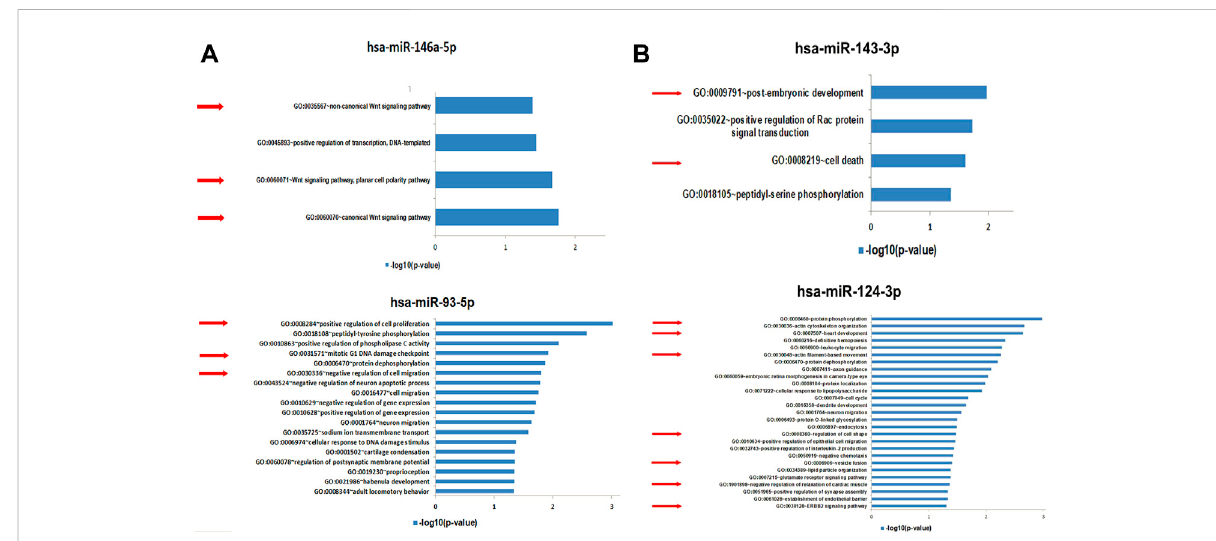
FIGURE 10 (A) Functional analysis for Gene Ontology (GO) biological processes associated with target genes identi fi ed by miRWalk algorithm to be potentially regulated by the selected microRNAs, miR-146a-5p and miR-93-5p, found to be up-regulated in EV-BMMSCs compared to EV-ADSCs. GOenrichmentanalysisofDEGswasretrievedusingDAVID.Themostsigni fi cantly( p < 0.05)enrichedGOtermsinbiologicalprocessarepresented. All the statistically signi fi cant values were negative 10-base log transformed. Selected GO biological process terms are indicated by red arrows. DEGs,differentiallyexpressedgenes;GO,geneontology (B) .FunctionalanalysisforGeneOntology(GO)biologicalprocessesassociatedwithtarget genes identi fi ed by miRWalk algorithm to be potentially regulated by the selected microRNAs, miR-143-3p and miR-124-3p, found to be up- regulated in EV-ADSCs compared to EV-BMMSCs. GO enrichment analysis of DEGs was retrieved using DAVID. The most signi fi cantly (P < 0.05) enriched GO terms in biological process are presented. All the statistically signi fi cant values were negative 10-base log transformed. Selected GO biological process terms are indicated by red arrows. DEGs, differentially expressed genes; GO, gene